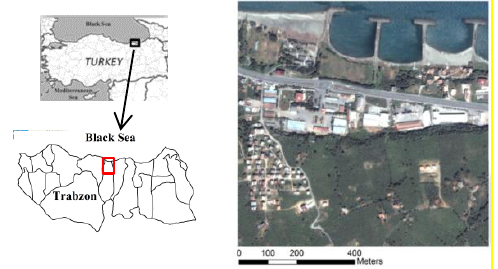
Figure 1. Location of the study area, Yomra district of Trabzon,